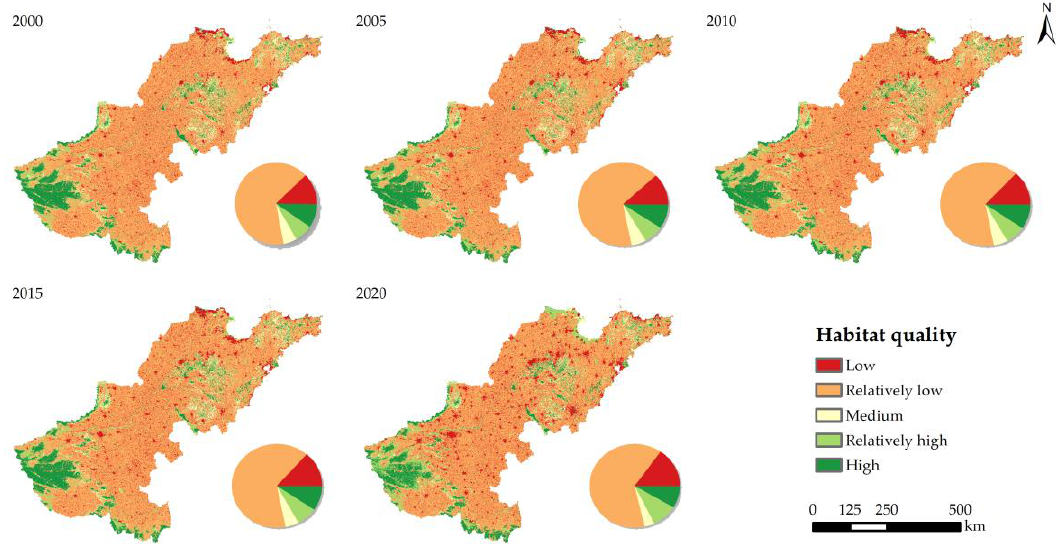
Figure 5. Spatial distribution of habitat quality along the Lower Yellow River from 2000 to 2020.